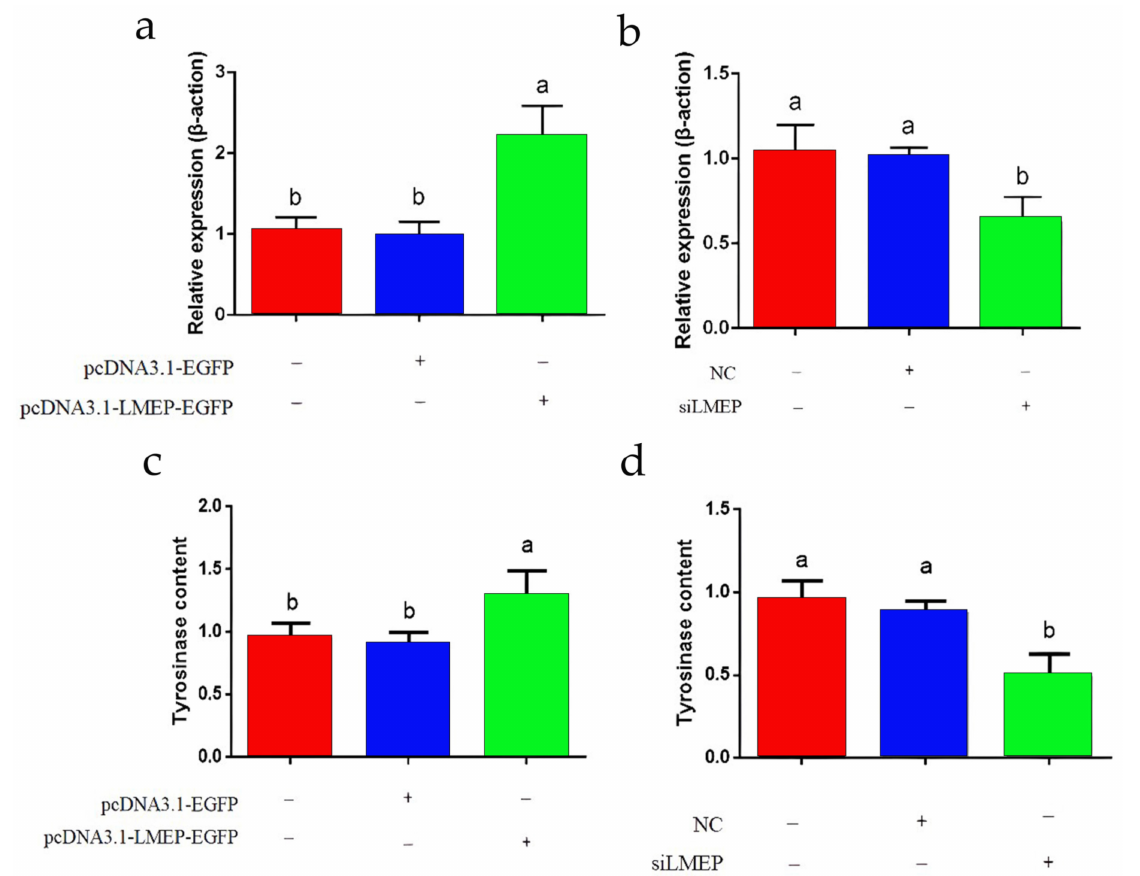
Figure 7. Effects of LMEP overexpression and interference on intracellular tyrosinase. ( a ) Detec- tion of LMEP gene overexpression. ( b ) Detection of LMEP gene interference. ( c ) Effects of LMEP overexpression LMEP on tyrosinase. ( d ) Effects of interfering with LMEP on